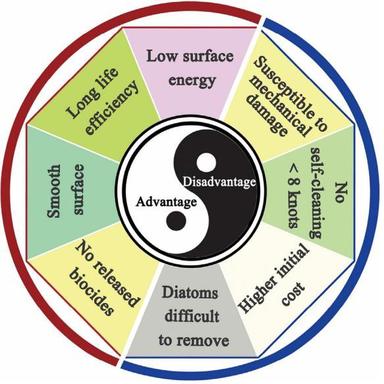
Summary of the advantages and disadvantages of applying FRCs.